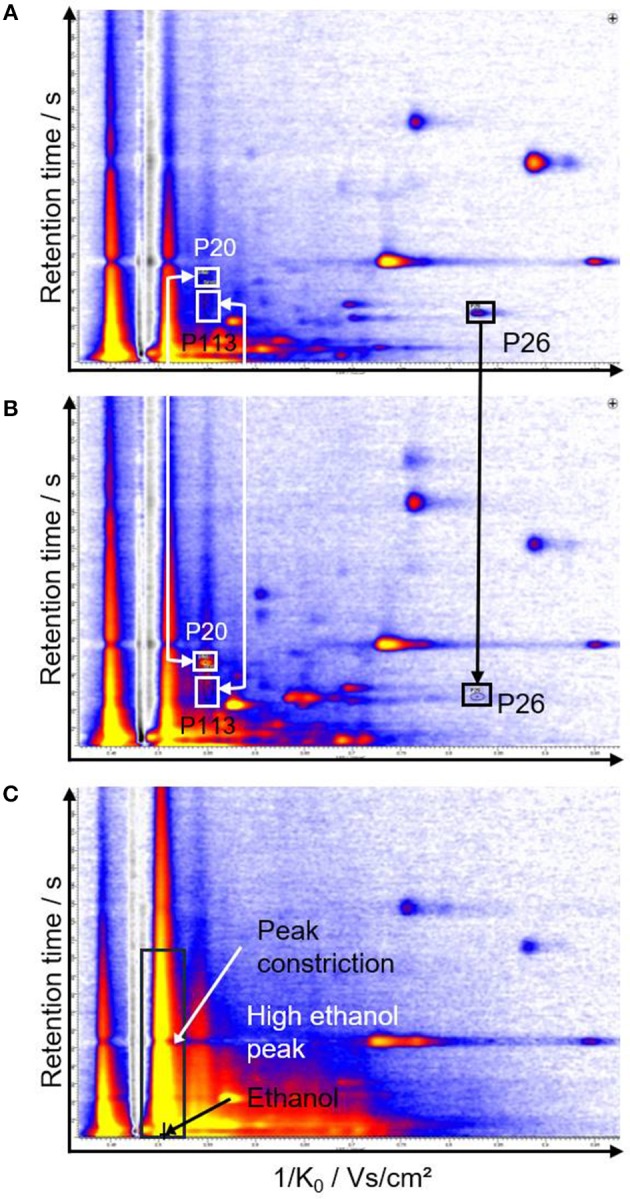
Representative chromatograms of unoccupied (A) and occupied incubators (B). The peaks that allow discrimination of the groups are indicated with arrows and rectangles. (C) shows a chromatogram with a strong ethanol peak leading to peak constriction.